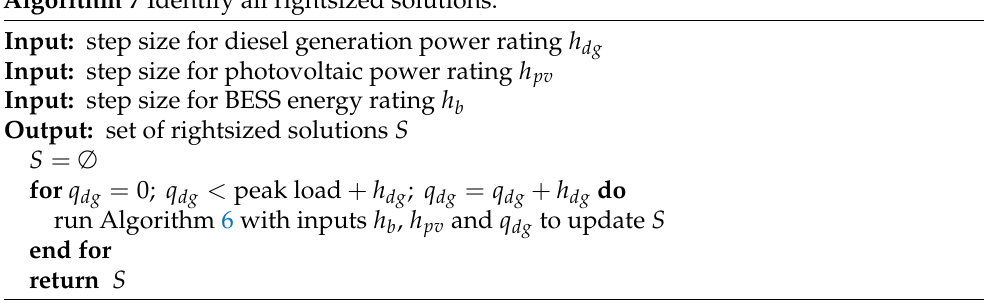
run Algorithm 6 with inputs h b , h pv and q dg to update